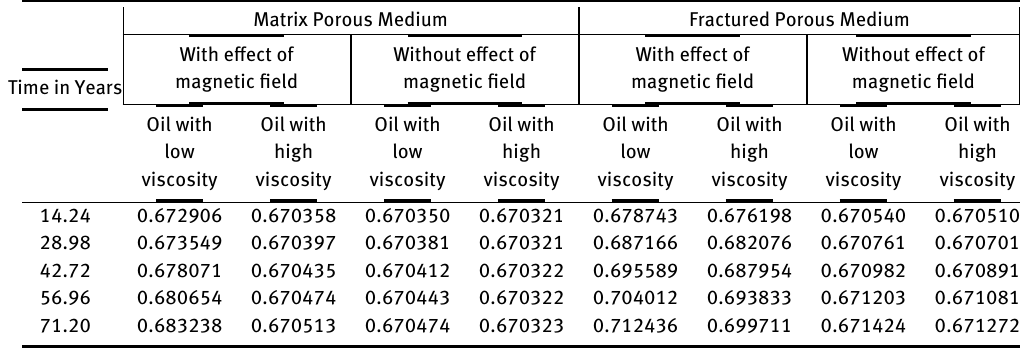
Table 2: Numerical values of saturation rate in fine sand in fractured and matrix porous media having low and high viscous reservoir fluids with and without magnetic field effect